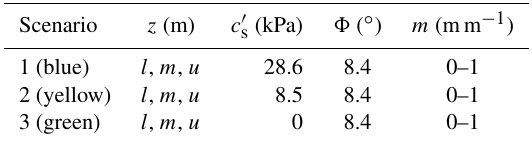
Table 2. Factor of safety scenarios for the reactivation of the entire landslide. L , m and u refer to the lower, mean and upper shear plane depth